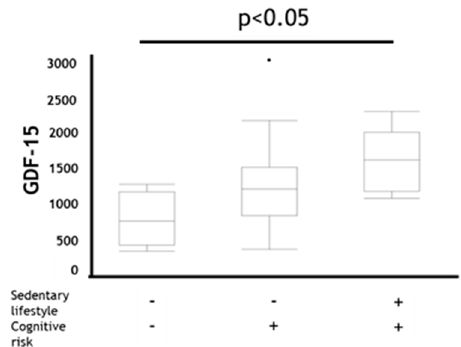
Figure 3. Comparison of GDF-15 in coexistence status with sedentary lifestyle and cognitive risk in COPD. Data are presented as boxplot including median (IQR). P -values compared among subjects by Kruskal–Wallis test. GDF-15: Growth Differentiation Factor-15 Sedentary lifestyle +: EX (MET × hours